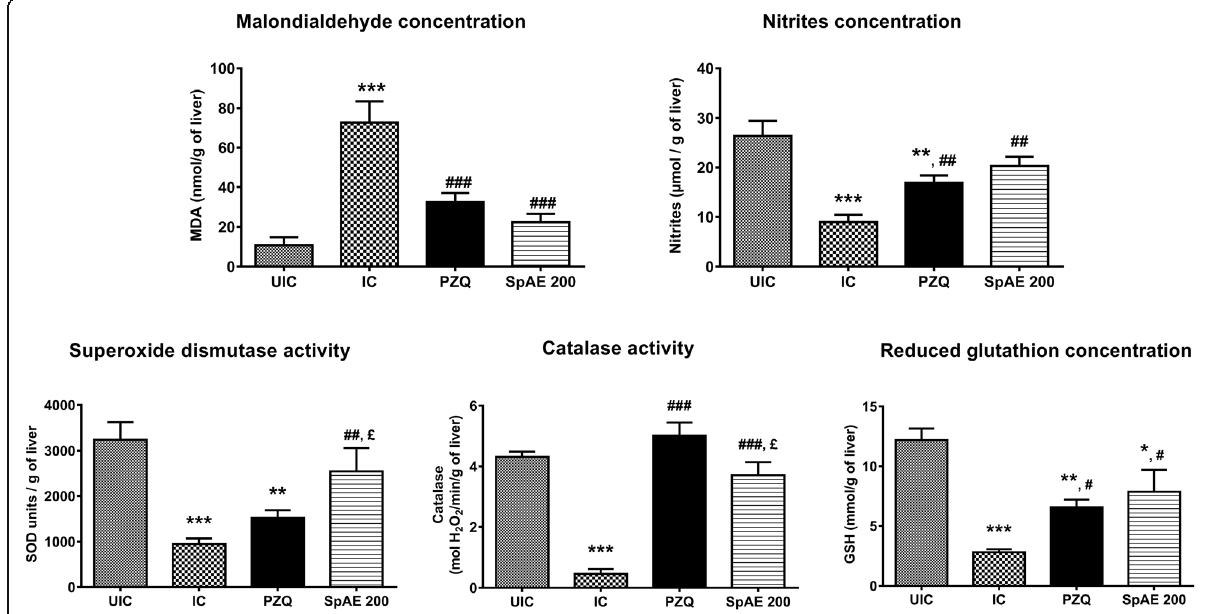
Fig. 3 Effect of oral treatment of Sida pilosa aqueous extract on the levels on some hepatic oxidative stress biomarkers of Schistosoma mansoni - infected mice. UIC: uninfected-untreated mice; IC: infected-untreated mice; PZQ: infected mice treated with praziquantel; SpAE 200: infected mice treated with Sida pilosa aqueous extract at 200 mg/kg. Data are expressed as mean ± SEM ( n = 6). ANOVA followed by Newman-Keuls multiple comparison test was used for statistical analysis. * p <0.05, ** p <0.01, *** p <0.001: values are significantly different from those of